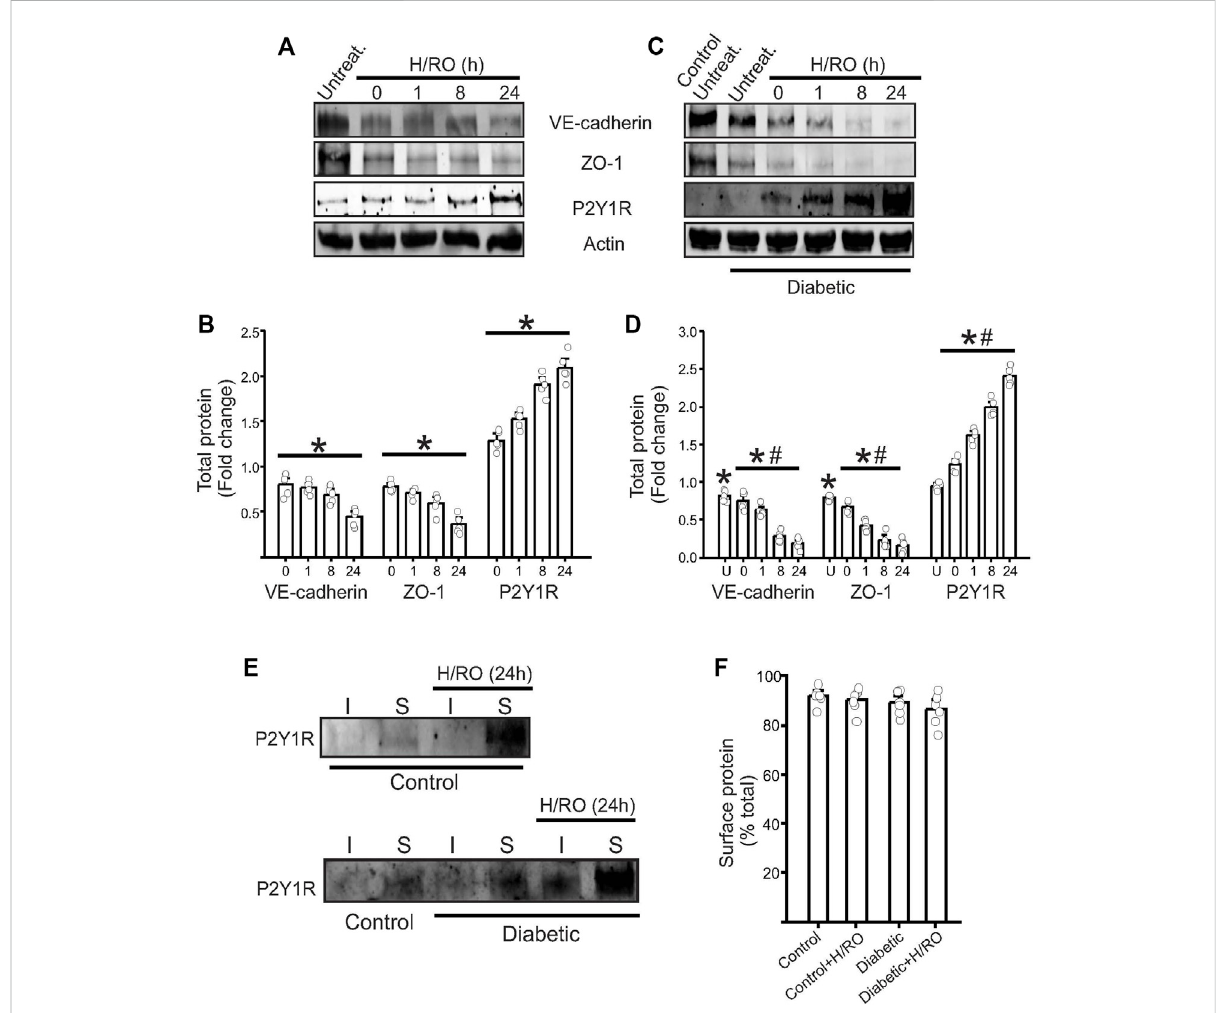
FIGURE 1 Upregulation of endothelial P2Y1 receptor post-H/RO decreases junctional protein expression. Representative Western blots showing the expression of VE-cadherin, ZO-1, P2Y1 receptor and actin in (A) , control and (C) , diabetic endothelial cells. (B,D) Bar graphs for the same presented fold change in total protein and as mean ± SE. n = 5 for each, * indicates p < 0.05 vs. normoxic control, # indicates p < 0.05 vs. untreated normoxic diabetic (U in bar chart). (E) Representative Western blots after surface biotinylation in control and diabetic cells showing P2Y1R expression in surface (S) and intracellular (I) fractions with or without H/RO (24 h). (F) Mean data showing the surface expression of the protein alone expressed as % total